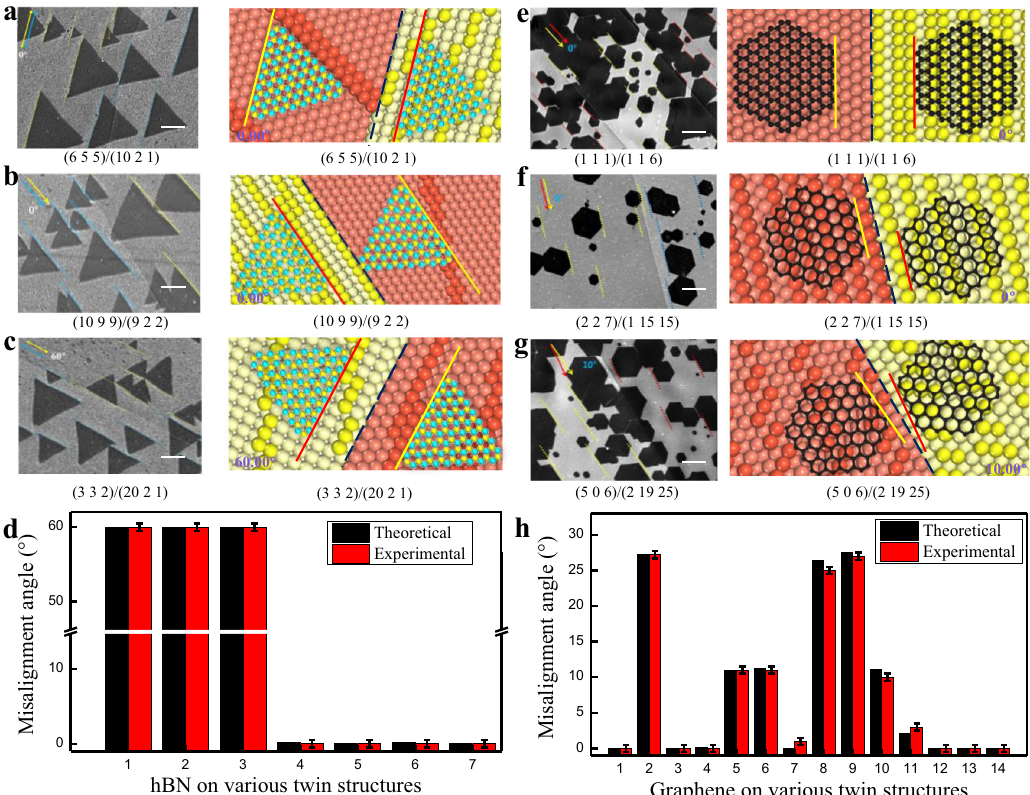
Fig. 3 Alignment of hBN and graphene islands on different twinned Cu surfaces. SEM images of typical 2D material alignment experimentally observed on twinned Cu surface (left panels) compared with theoretical prediction (right panels). a – c are typical hBN islands grown on twinned Cu surfaces, in which all hBN islands shown in ( a ) and ( b ) are parallelly aligned while those shown in ( c ) show antiparallel alignment. d the theoretical prediction and experimental statistics of the misalignment angle of hBN grown on different substrates (The error bar is the standard deviation of raw data.). e – g , are typical graphene islands grown on twinned Cu surfaces, in which ( e ) and ( f ) show parallelly aligned graphene islands while islands in ( g ) are misaligned on both sides of the twin boundary. The angle between the 2D island edge and the twin boundary is marked in the corresponding theoretical diagram. Surface indices of the twin crystals are shown in each fi gure. The scale bars in all graphs are 10 μ m. h the theoretical prediction and experimental statistics of the misalignment angles of graphene grown on different substrates (The error bar is the standard deviation of raw